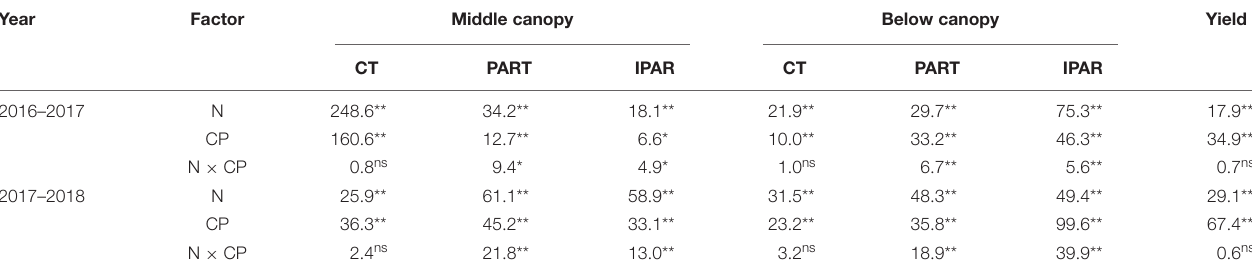
TABLE 3 | Variance analysis of applied nitrogen and intercropping on canopy light environment and yield of wheat. Year Factor Middle canopy Below canopy Yield CT PART